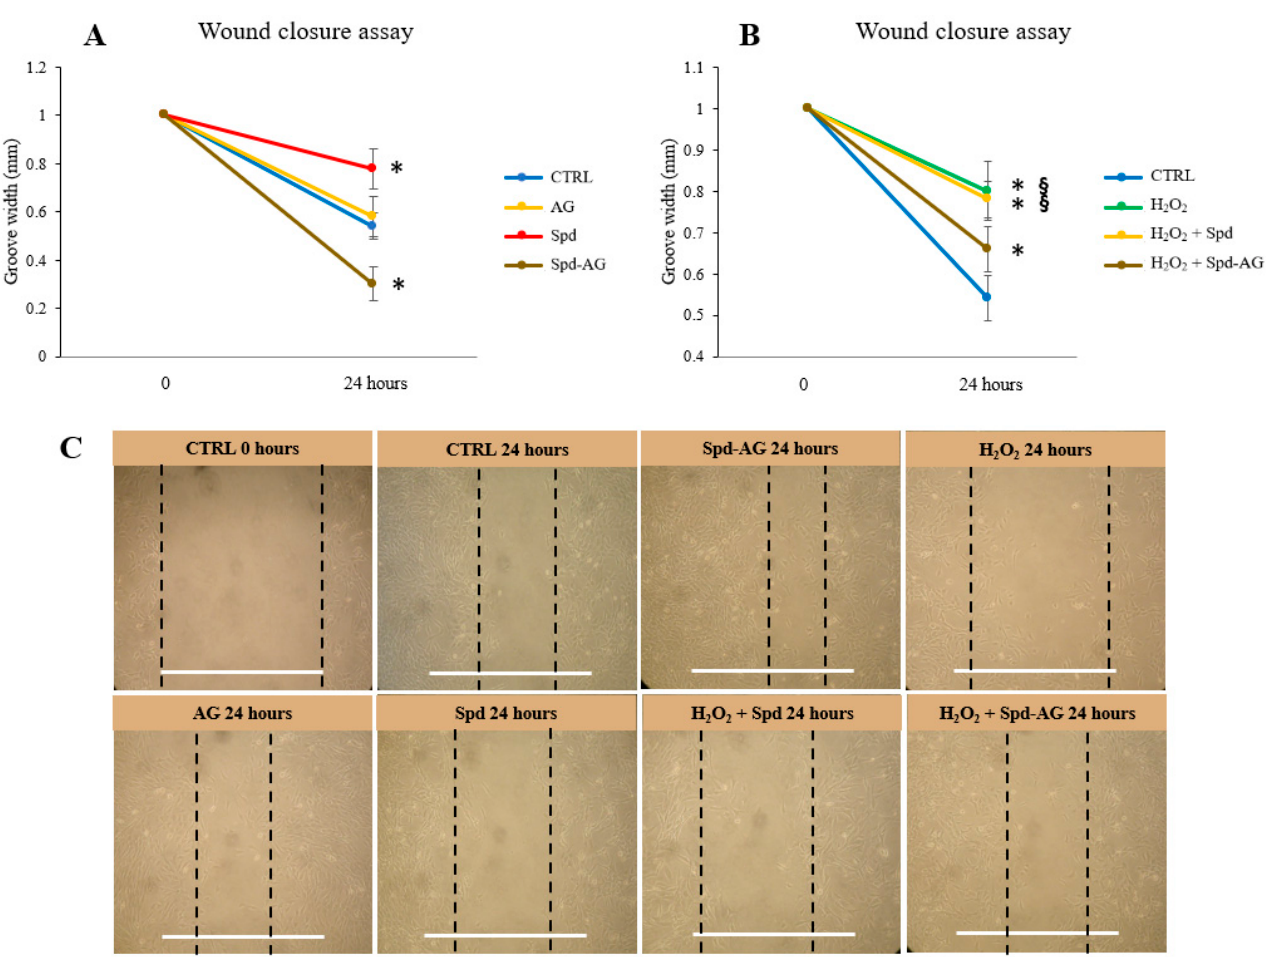
Figure 6. Wound closure assay. Before each treatment, a wound of 1 mm was created in the culture plate. Cells were treated with Spd 10 μ M, AG 1 mM, H 2 O 2 0.3 mM and combined treatments or a vehicle for 24 h. The sulcus width was then measured in control and treated cells. ( A ) Effect of Spd, AG and Spd ‐ AG. ( B ) Effect of H 2 O 2 and combined treatment with Spd and Spd ‐ AG. ( C ) Representative images of all treatments. White bars correspond to 1 mm. Data and representative images presented are the mean ± SD of three experiments, each performed in triplicate. One ‐ way ANOVA was performed, followed by Bonferroni’s multiple comparison tests. * p < 0.05 vs. CTRL; § p < 0.05 vs. H 2 O 2 .